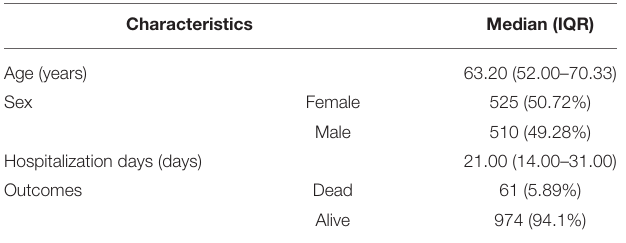
TABLE 2 | Laboratory findings within 48h after admission of 1,035 COVID-19